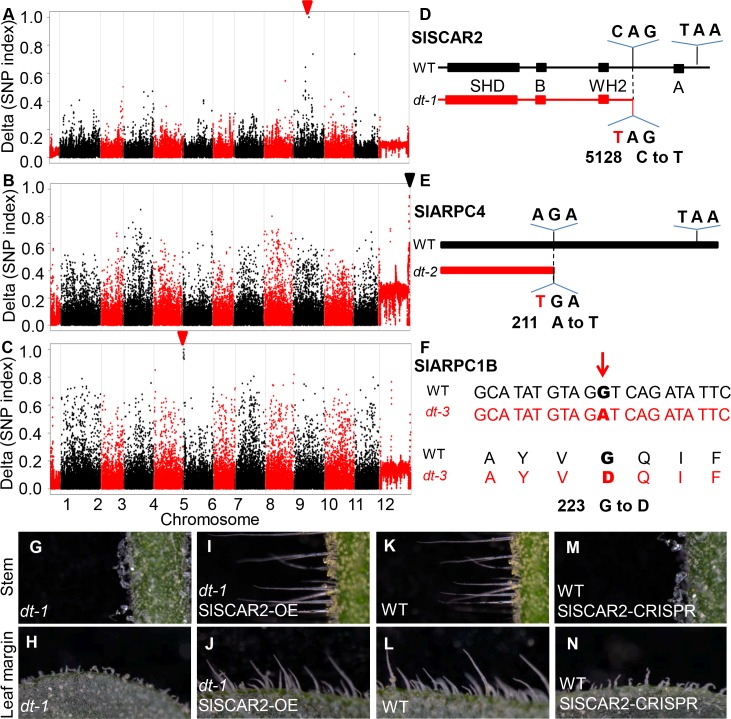
Mapping and verification of the mutation in dt mutants.(A-C) Mapping of dt-1 (A), dt-2 (B) and dt-3 (C) by BSA-seq analysis. Triangles show the causal mutations with high frequency (Ideally 100% having the variant allele). (D-F) The location of causal mutations in SlSCAR2 of dt-1 mutant (D), SlARPC4 of dt-2 mutant (E), and SlARPC1B of dt-3 mutant (F). (G-N) Complementary verification of SlSCAR2. Over-expression of SlSCAR2 in dt-2 mutant rescued the distorted trichome phenotype (G-J), and knockout of SlSCAR2 by CRISPR-cas9 in WT resulted in distorted trichomes (K-N).